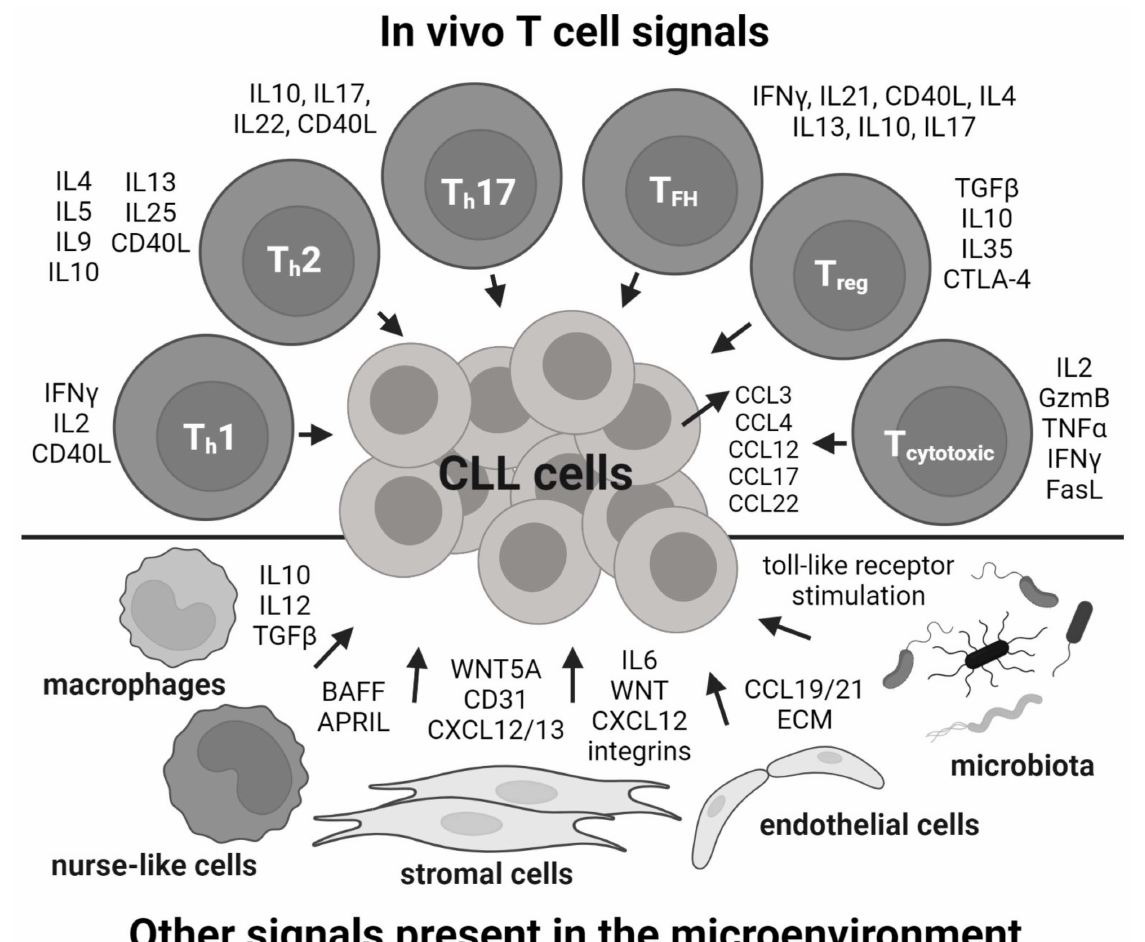
Figure 1. Microenvironmental signals provided by various T-cell subsets and other cell types in immune